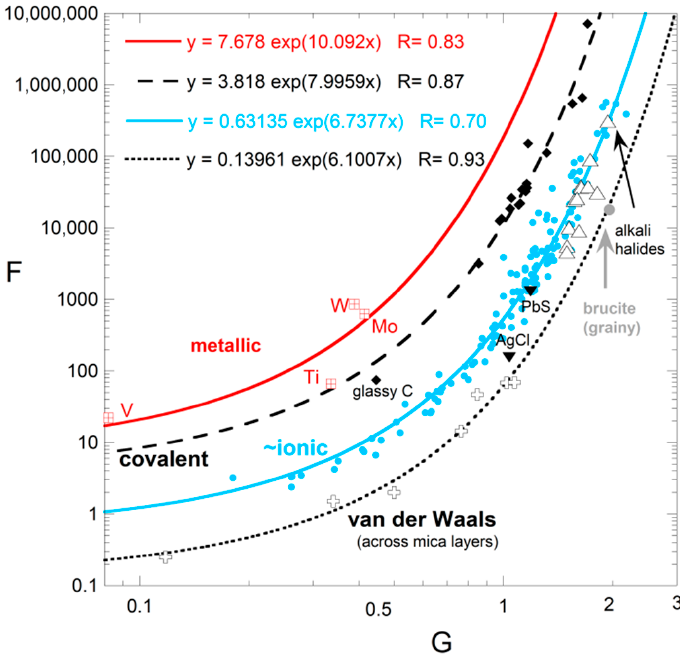
Figure 5. Correlation of fitting coefficients F and G obtained using (21) for all 173 measurements compiled in [4] (Table 7.2) plus metals (Table 1; also [9,11,24,25]). Thicknesses exceed ~1 mm. Fits for anisotropic substances are made to each orientation explored. Exponential fits are provided for the various bonding types. Grainy samples (e.g., brucite, Mg(OH) 2 , and ceramics) fall slightly lower on the curves than similar crystals, due to porosity reducing D . Salts lie slightly below the curve for the silicates, which have ionic-covalent bonding. AgCl and metal Ti measurements were over small T -ranges, so F and G are less well constrained. Modified after Figure 7.5 in Hofmeister [4] with